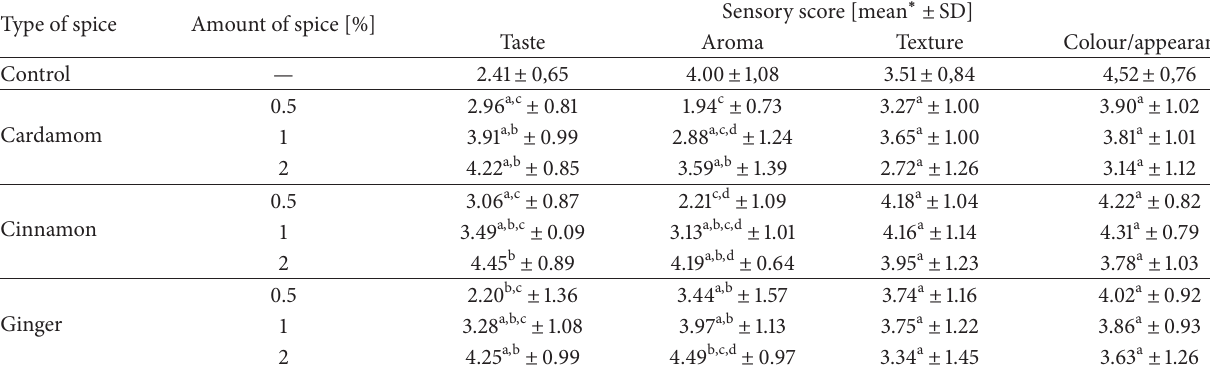
Table 1: The results of the sensory score of honey with